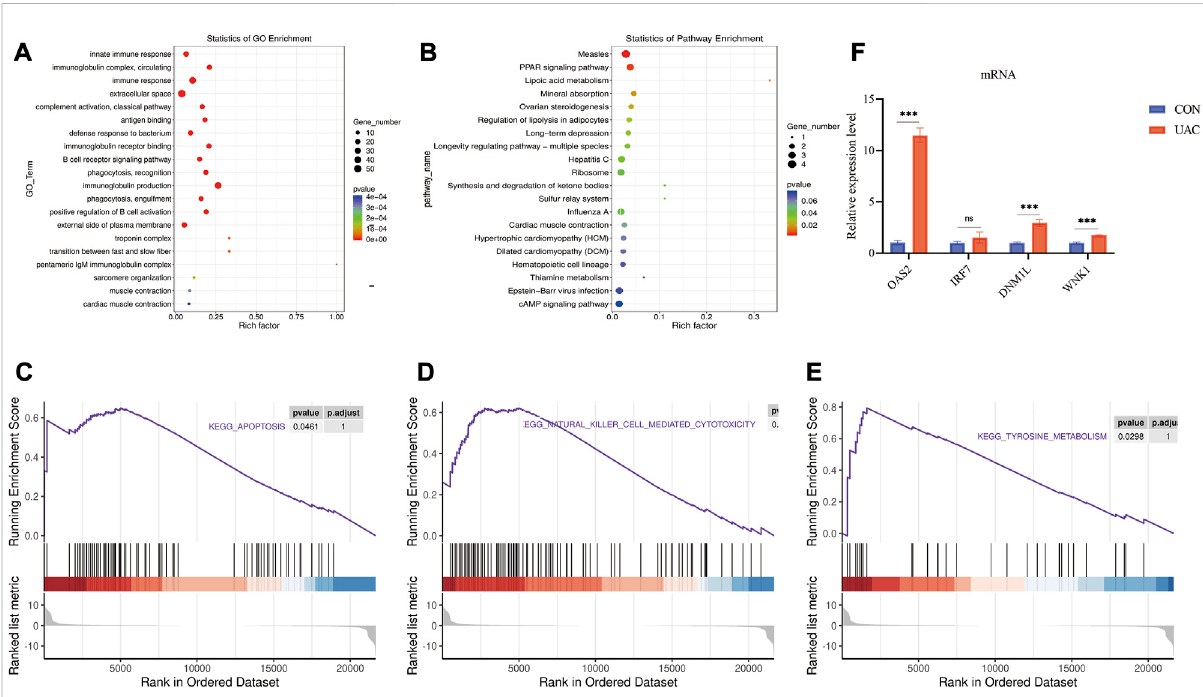
FIGURE 3 (A) show some of the signi fi cantly enriched GO terms associated with the mRNA target genes. (B) shows some of the signi fi cantly enriched pathways associated with the mRNA target genes. The size of the spot indicates the number of genes enriched in the pathway, and the color of the spot indicates the signi fi cance level of the enriched pathway. (C,D and E) are gene set enrichment analysis (GSEA) results. C presents the tyrosine metabolism results. D presents the natural killer cell-mediated cytotoxicity results. E presents the apoptosis results. (F) qRT-PCR validation of the essential genes of enrichment analysis including Klrk1, Adipoq, Cryab, Hspa1b. ** p < 0.01.